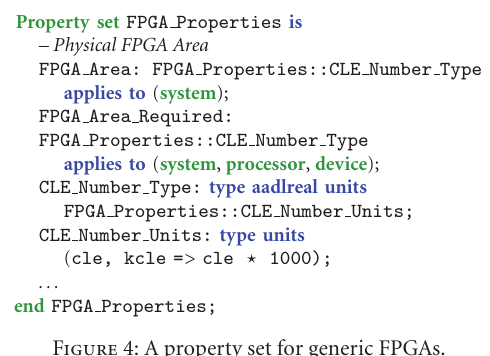
Figure 4: A property set for generic FPGAs.